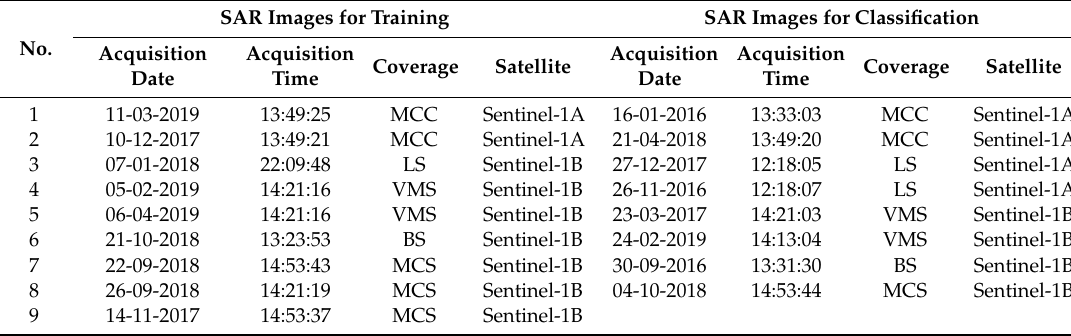
Table 1. List of Sentinel-1 SAR images used for training and classification in